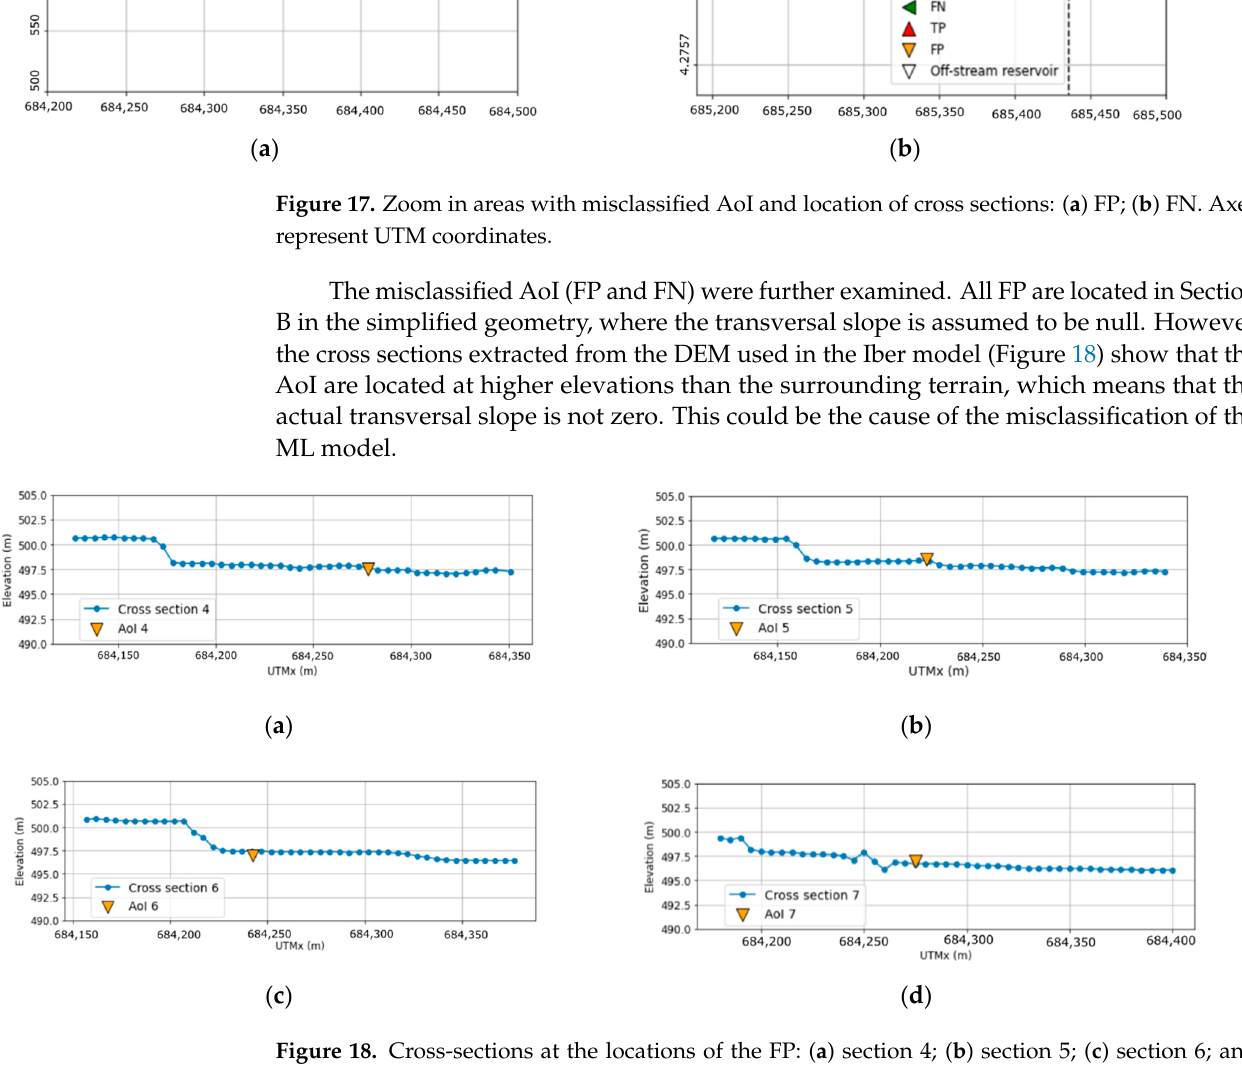
Figure 18. Cross-sections at the locations of the FP: ( a ) section 4; ( b ) section 5; ( c ) section 6; and ( d ) section 7.